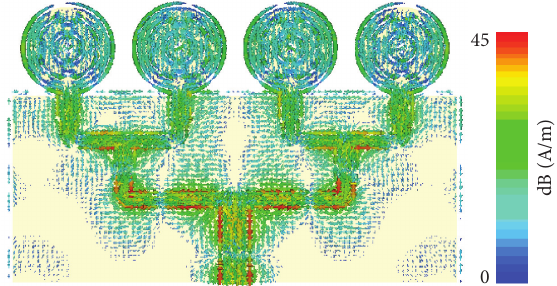
Figure 12: Surface current distribution for the proposed